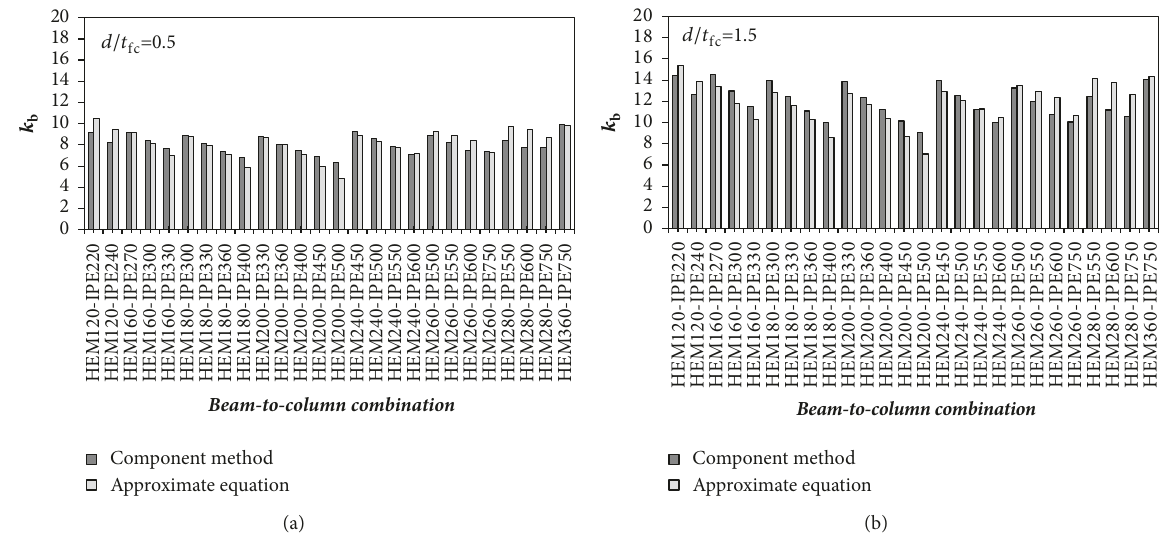
Figure 12: Accuracy of the approximate equations for selected values of the ratio 𝑑/𝑡 fc : normalized stiffness.